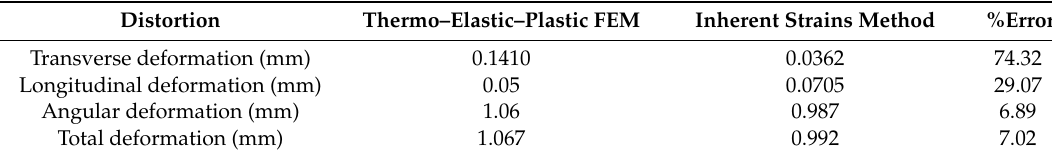
Table 3. Simulation results of FEM analysis and inherent strains method